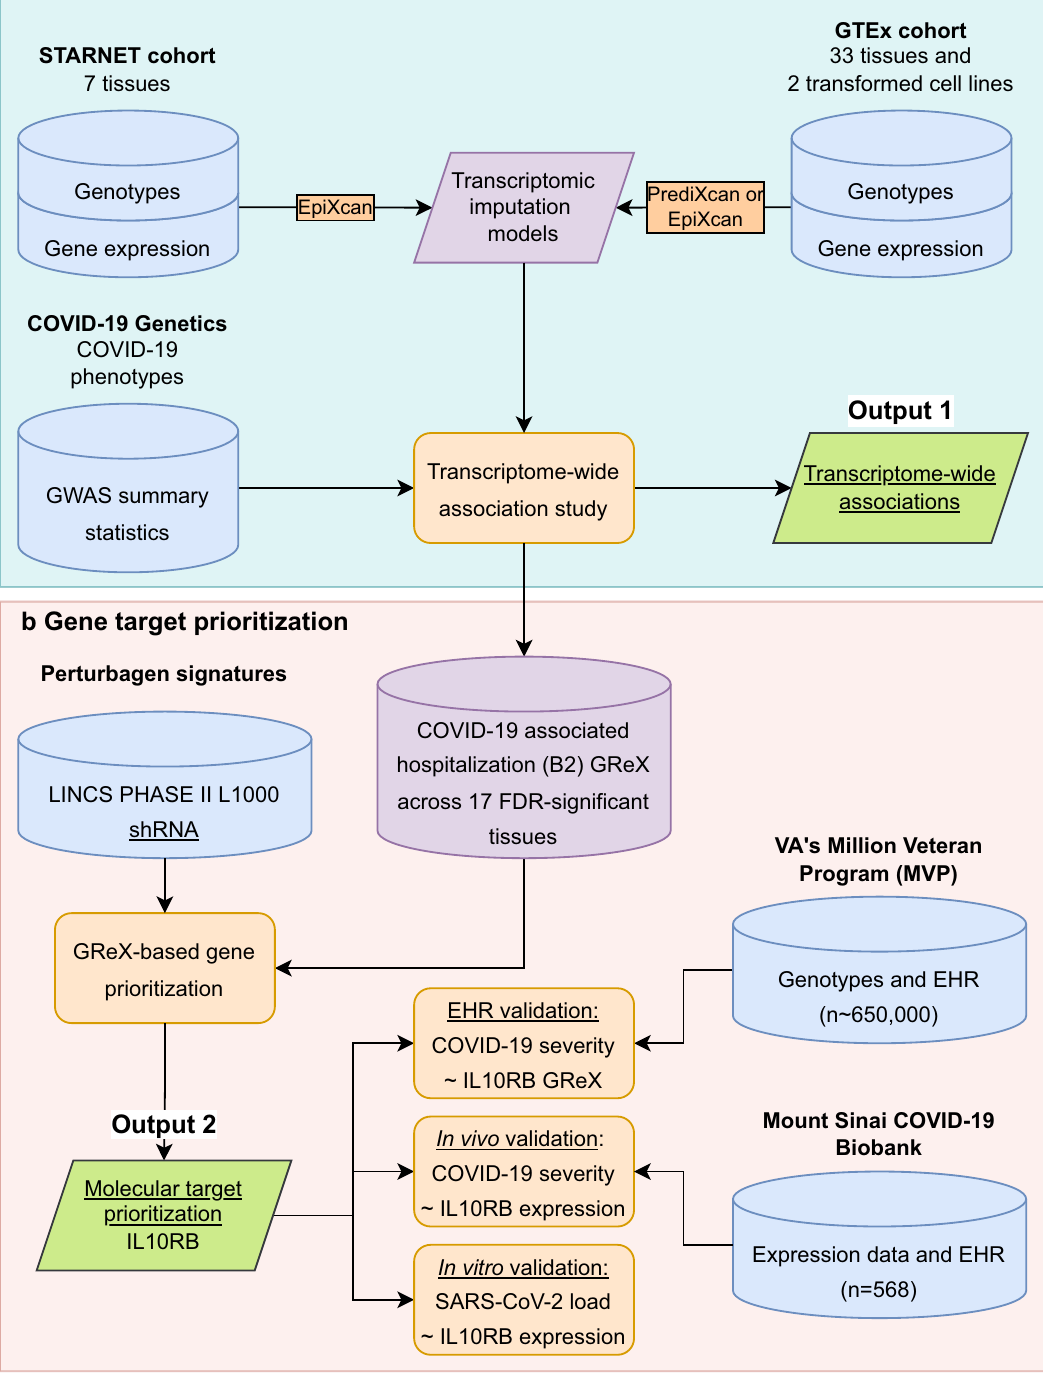
Fig. 1 Data-driven GReX (genetically regulated gene expression)-based approach for molecular target prioritization for COVID-19. a Multi-tissue ( n = 42) transcriptome-wide association study using: (1) GWAS summary statistics from the COVID-19 Host Genetics Initiative for COVID-19 phenotypes, and (2) transcriptomic imputation models trained in the STARNET (Stockholm-Tartu Atherosclerosis Reverse Network Engineering Task) and GTEx (Genotype-Tissue Expression) cohorts. b Gene target prioritization via integration of multi-tissue transcriptomes (17 FDR-signi fi cant tissues for COVID-19 associated hospitalization) with perturbational transcriptomic pro fi les from LINCS (library of integrated network-based cellular signatures) identi fi ed IL10RB as the top candidate. In a series of validation experiments we found that: (1) blood IL10RB genetically regulated gene expression (GReX) is associated with COVID-19 severity in the VA ’ s Million Veteran Program —“ EHR validation ” , (2) COVID-19 severity was associated with increased assayed IL10RB expression in patients ’ blood —“ in vivo validation ” , and (3) increasing IL10RB expression resulted in higher SARS-CoV-2 viral load in two different model cell systems for SARS-CoV-2 infection and replication —“ in vitro validation ”